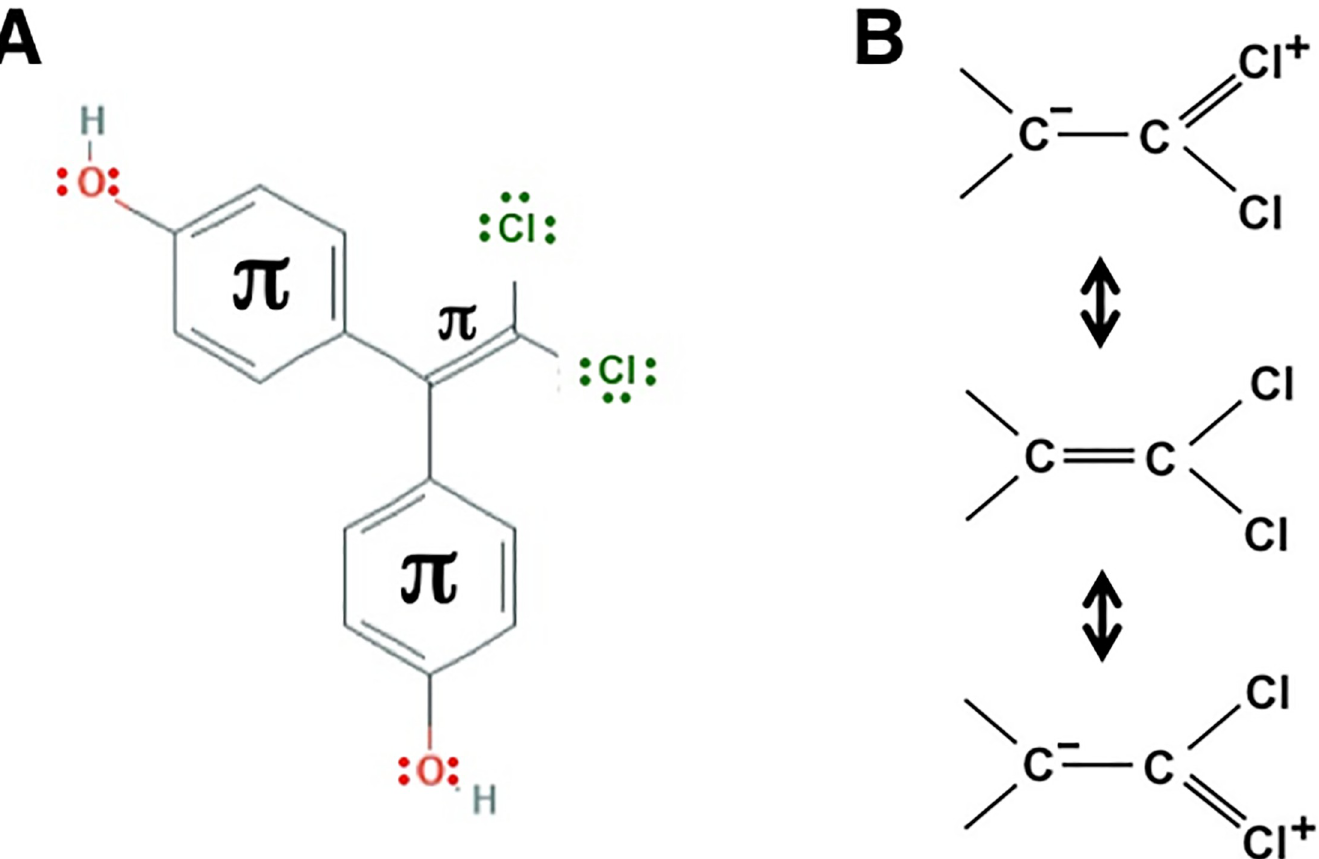
Fig 8. Interactive chemical structure models of BPC. Chemical constitution formulas are shown together with the electronic formula of chlorine and oxygen atoms ( A ), while the canonical forms or resonance structures are expressed for the vinylidene chloride moiety of BPC ( B ).